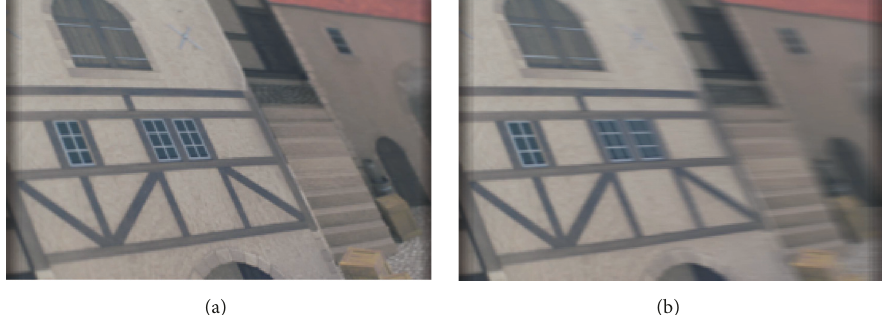
Figure 5: (a) is the refocus result by using the correct inclined plane parameters, and it is an all-in-focus image. (b) is the result by using wrong parameters, and it is noticed that there is only defocus blur in horizontal direction.